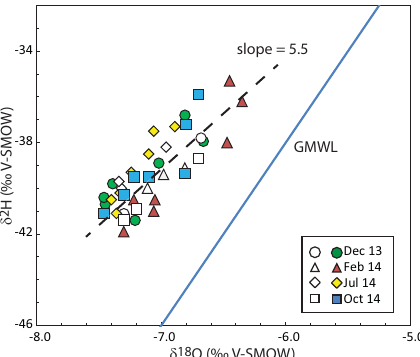
Figure 6. δ 18 O vs. δ 2 H values for the main Ovens River (open sym- bols) and its headwater tributaries (closed symbols) in the four sam- pling rounds; GMWL = Global Meteoric Water Line. Data from Ta- ble 1.